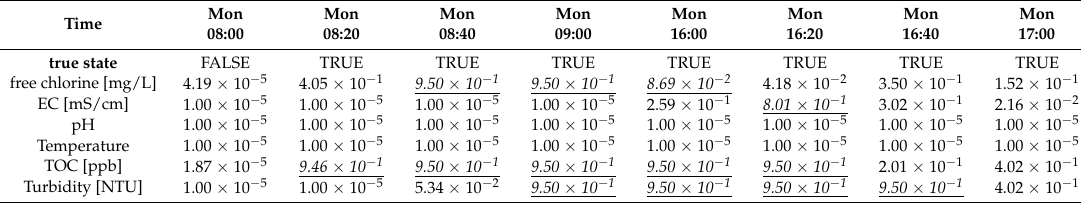
Table 2. Updated probability of contamination events in a single